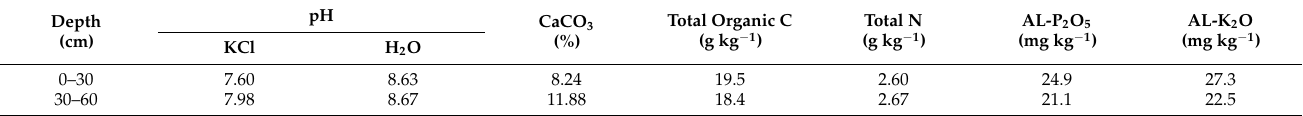
Table 1. Physico-chemical properties of soil at the study site.